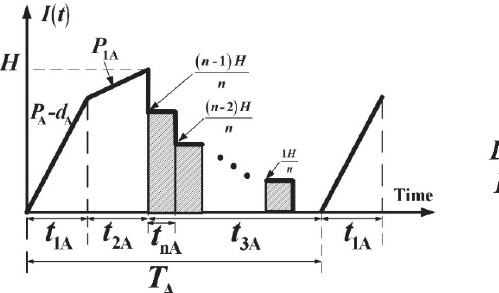
Fig. 3. Inventory level of finished products in t 3A of the proposed EMQ- based system